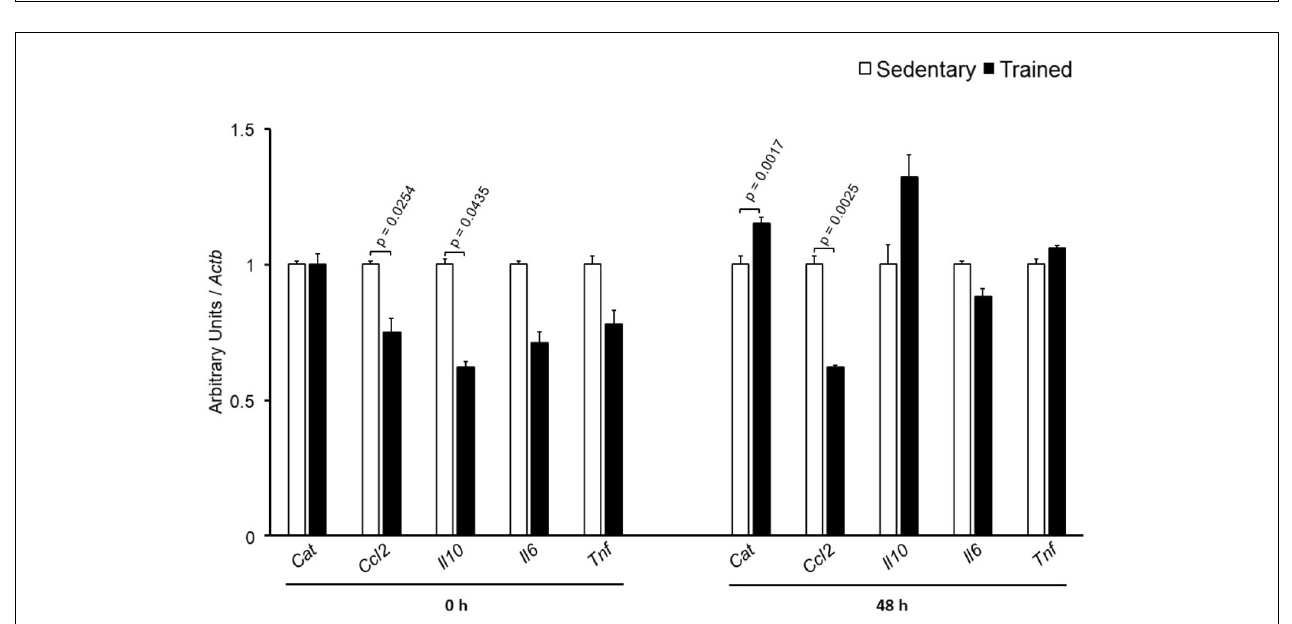
FIGURE 2 | Expression of inflammation-related genes in peritoneal macrophages harvested from sedentary (S) and trained (T) mice. Peritoneal macrophages from CETP-tg S and T were harvested immediately (0 h; S n = 5; T n = 5) or 48 h (S n = 7; T n = 7) after the last session of exercise. The expression of genes was analyzed by RT-qPCR and expressed as arbitrary units corrected per Actb . Comparisons were done by the unpaired Student t -test (mean ± SEM).